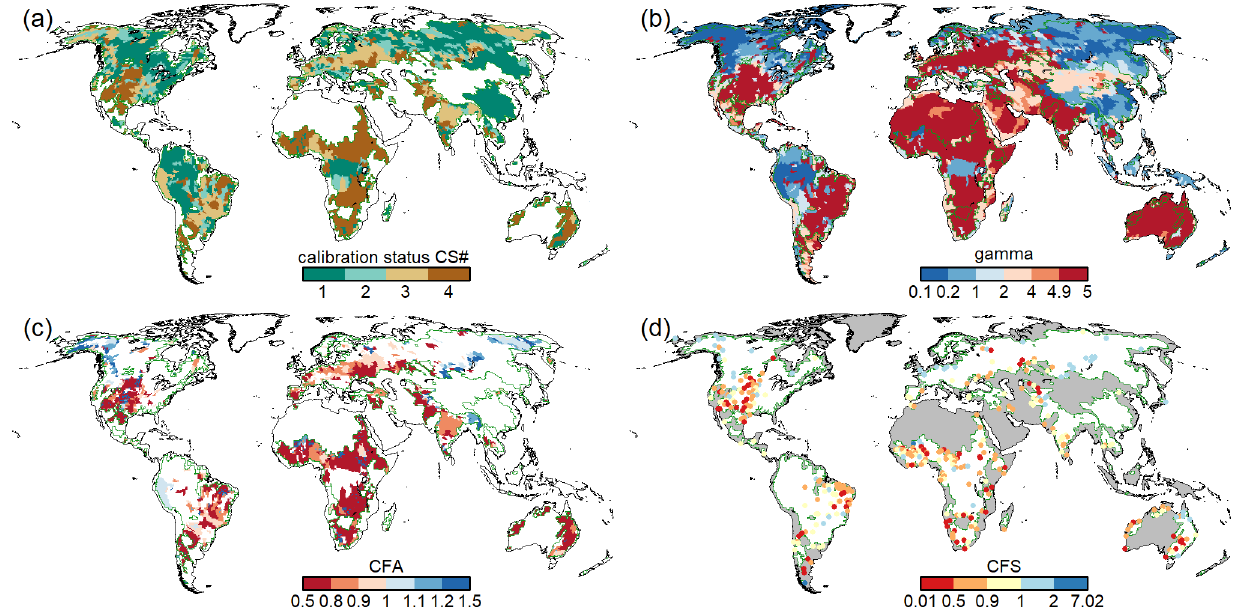
Figure 4. Results of the calibration of WaterGAP 2.2d to the standard climate forcing with (a) the calibration status (see Sect. 4.9.1) of each calibration basin, (b) calibration parameter γ , (c) areal correction factor CFA and (d) station correction factor CFS. Grey areas in (d) indicate regions with regionalized calibration parameter γ and for (a) – (d) dark green outlines indicate the boundaries of the calibration basins.